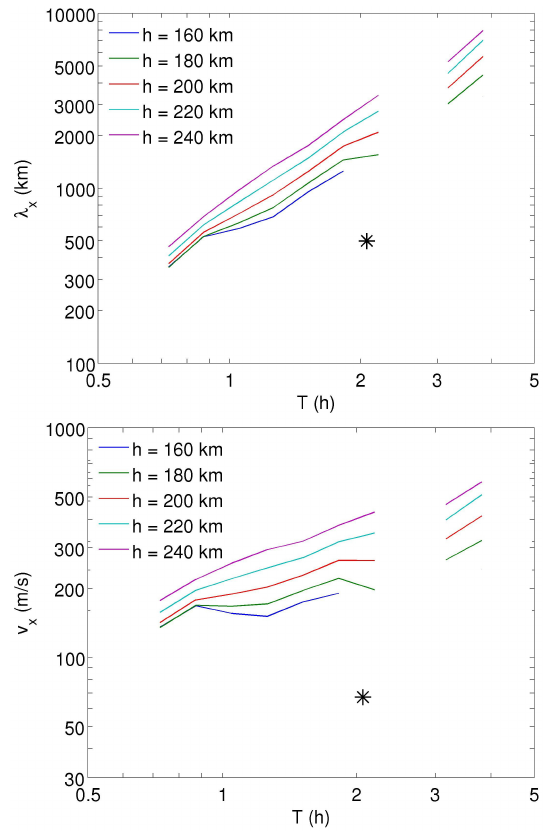
Figure 18. Horizontal wavelengths (upper graph) and horizontal phase speeds (lower graph). Lines: parameters calculated from the EISCAT results as functions of period length and altitude, using Hines’ dispersion equation. Stars: parameters detected from the GPS results. Note that all values are with respect to a reference frame fixed to the